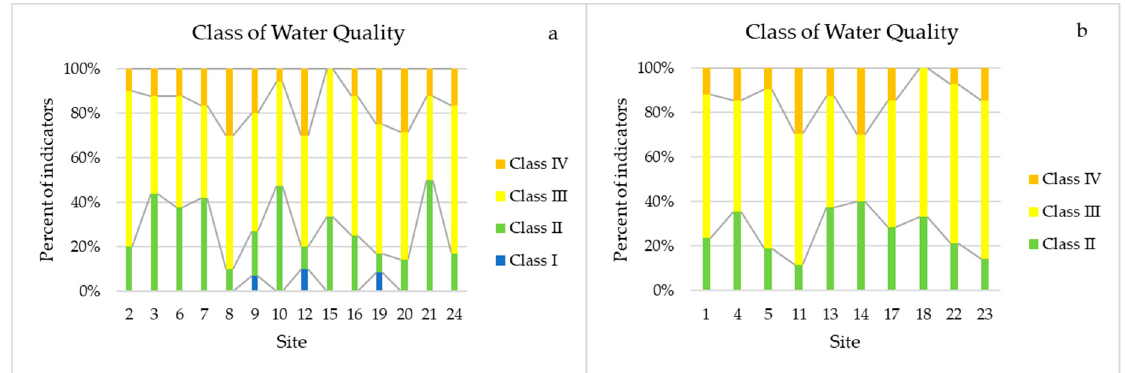
Figure 9. Water quality classes for S and M ( a ) and L and XL ( b ) rivers in the Siversky Donets river basin (Ukrainian part). Colors of water quality classes are presented according to the Water Framework Directive [14].